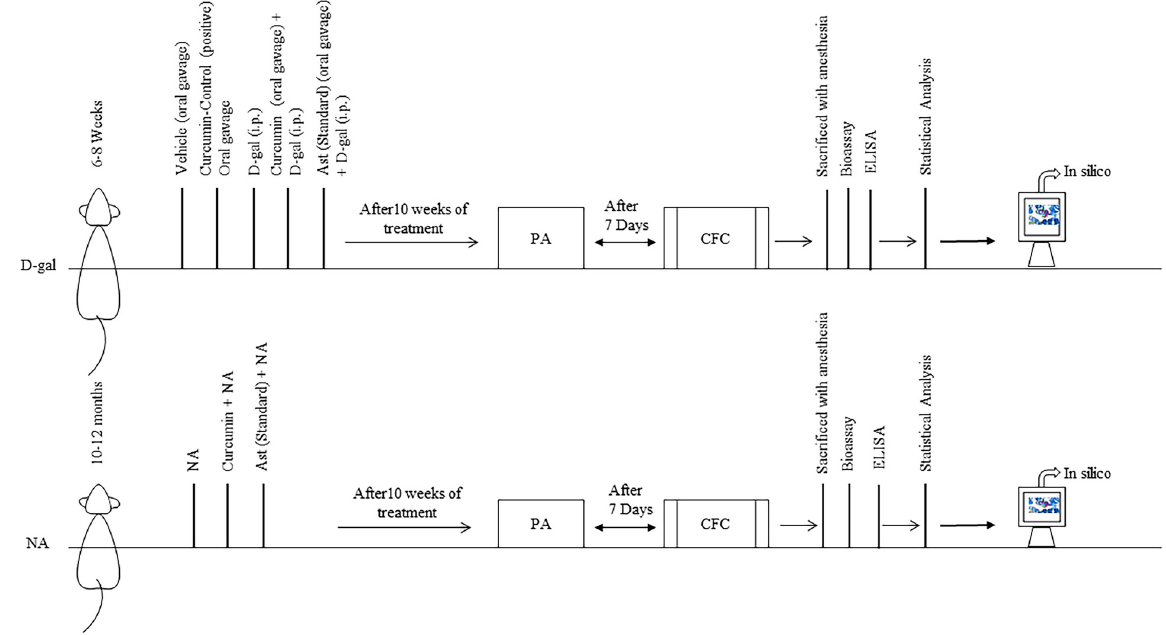
Fig 1. Schematic diagram of total experimental procedures: The treatment was continued for ten weeks. After that, the behavioral tests were performed using Passive Avoidance (PA) and Contextual Fear Conditioning (CFC). The biomarkers were detected after completing the behavioral tasks. In-silico studies were used to determine curcumin’s binding affinity to targeted proteins.